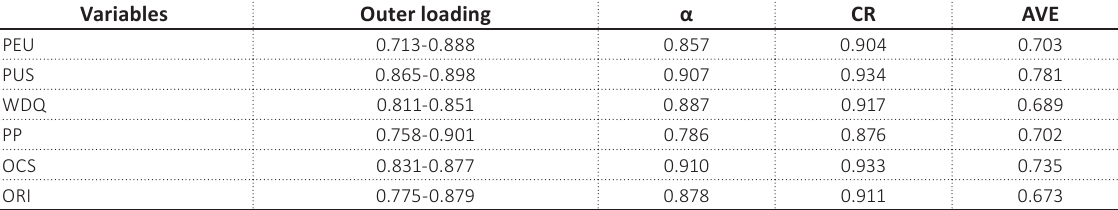
Table 3. Reliability and validity results